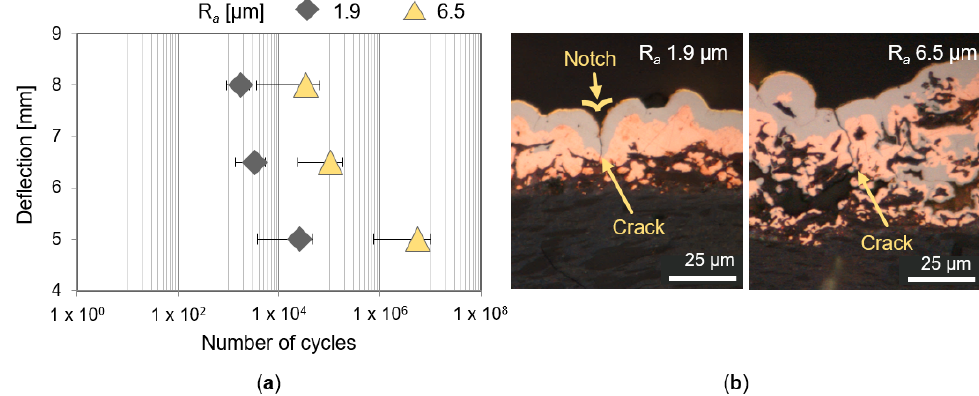
Figure 7. ( a ) Number of cycles dependent on the deflection and the roughness R a , whereas the nickel thickness was 5 µm; ( b ) Cross-section image of conductor tracks after mechanical failure.